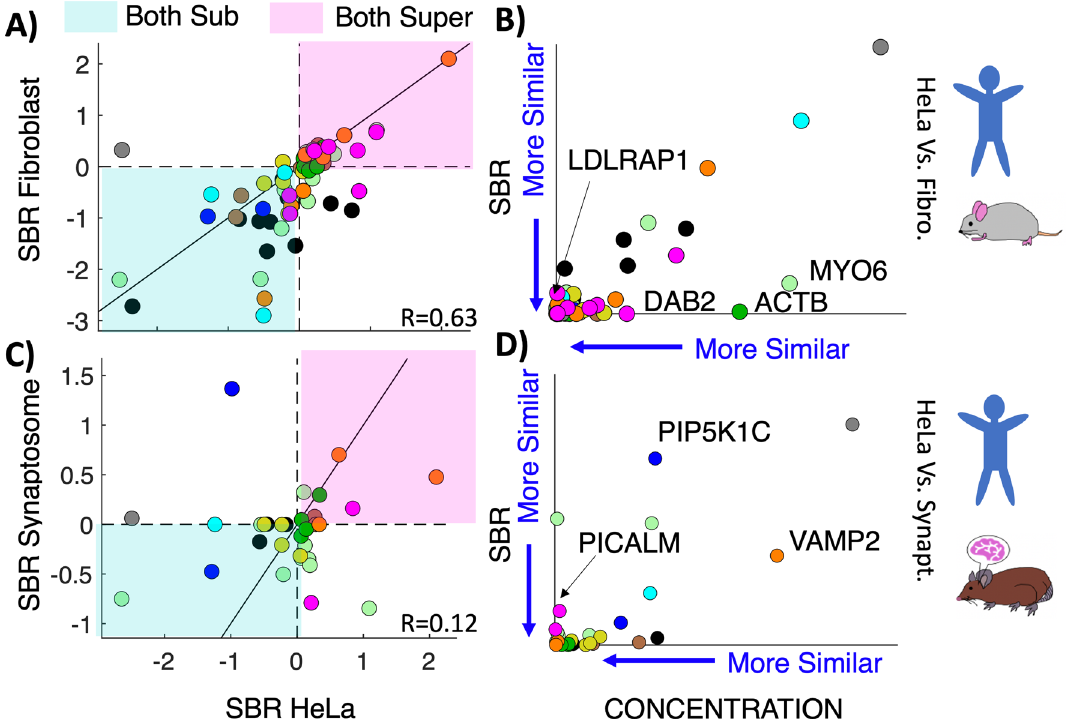
Figure 6. Stoichiometry is similar between HeLa and fibroblasts, with deviations largely correlating with large differences in concentration across cell types. ( A ) SBR values for fibroblast cells vs HeLa show significant correlation, with R = 0.63. ( B ) The SBR ratios between the cell types are more similar as the concentrations between the cell types are more similar, as expected and emphasized by all the points near the origin. Moving out along the diagonal are proteins that have increasingly distinct concentrations, typically driving large deviations in SBR values. Outliers are therefore along the axes, where MYO6 and DAB2 have relatively distinct abundances between the cell types, but very similar SBRs. In this case, these interacting proteins both have correlated decreases in abundance, contributing to their similar stoichiometry. LDLRAP1 has almost identical concentration in both cell types, but distinct stoichiometry, due to the drop in its competitor DAB2’s abundance. ( C ) The SBR is quite distinct in the synaptosome relative to HeLa, with an R = 0.12. ( D ) The variation in SBR is again largely resulting from large variations in concentration between the cell types. PICALM has very similar abundance in both cell types, but its cargo, including VAMP2, has a dramatic increase in abundance, contributing to a distinctive